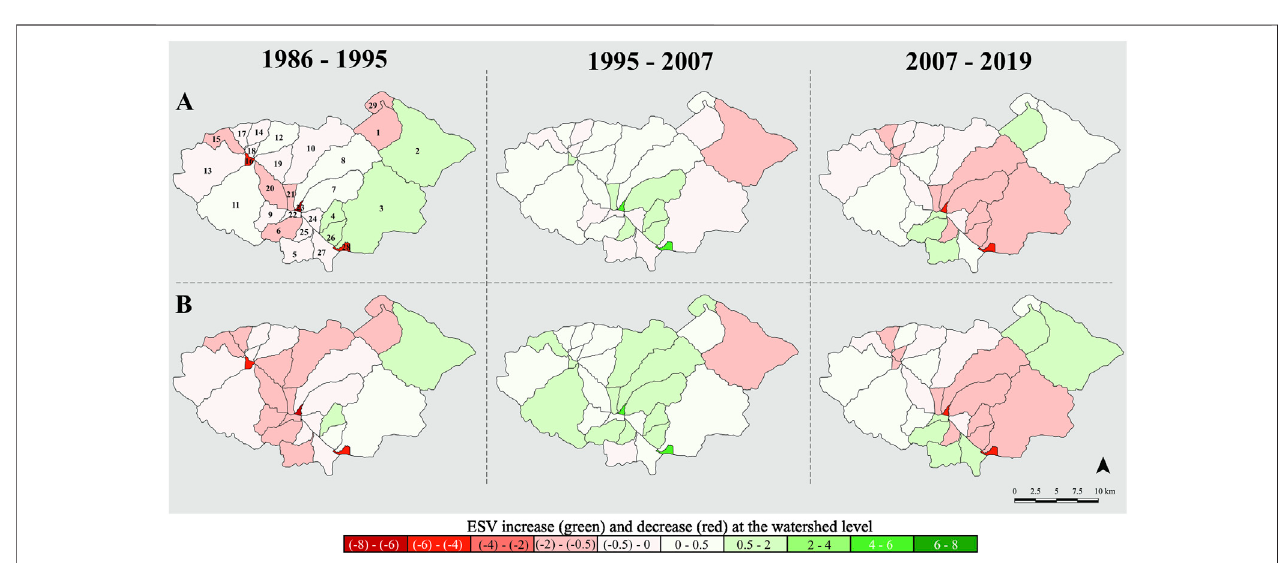
FIGURE 4 | Spatial distribution of ESV increase and decrease (A) and adjusted by the in fl ation (B) at the watershed level in the Marangani district over the three periods (ESV units in 10 3 $).